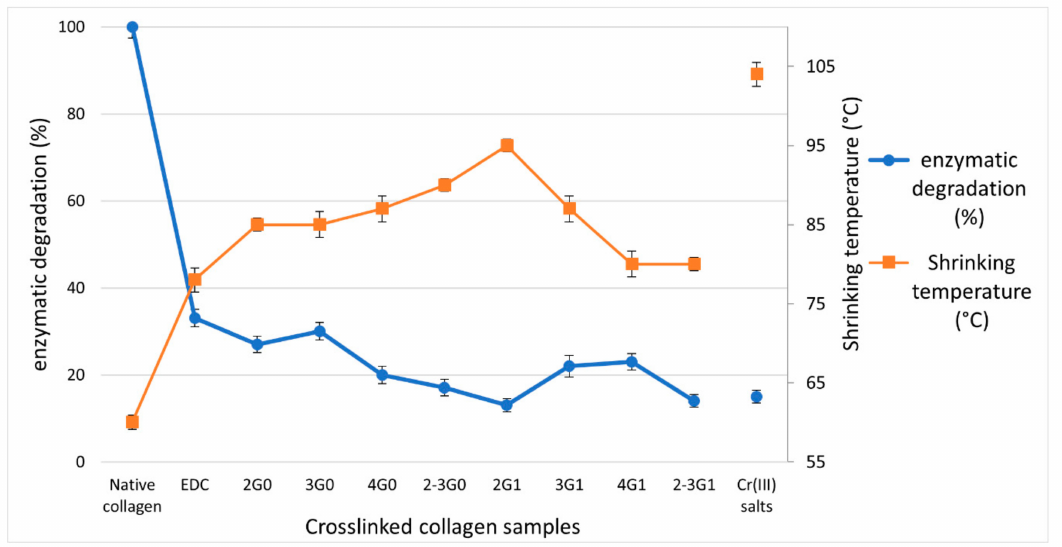
Figure 2. Comparison of Ts ( ◦ C) data (measured by DSC) and collagenase wt% degradation of native uncross-linked collagen powder, after cross-linking with COOH coll / EDC / NHS 1 / 2 / 2 (mol / mol / mol) ratio and cross-linked with chromium sulfate salts (5